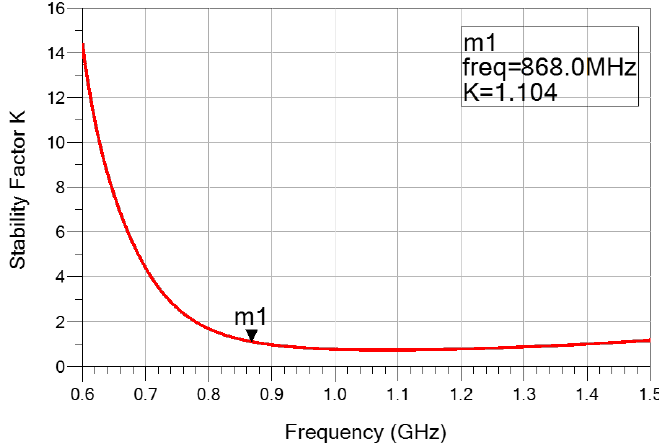
Figure 7. Simulation of the stability of the designed LNA